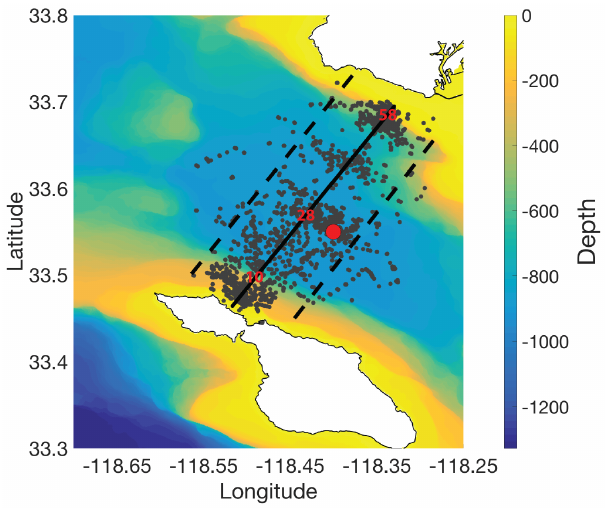
Figure 1. Glider deployment map and idealized glider transect. Slocum electric gliders were deployed in 2013 and 2014 between the Palos Verdes Peninsula and Catalina Island in the San Pedro Channel. The San Pedro Ocean Time-series (SPOT) station, lo- cated at 33 ◦ 33 (cid:48) 00 (cid:48)(cid:48) N and 118 ◦ 24 (cid:48) 00 (cid:48)(cid:48) W, is indicated by the red dot. Glider surfacings are indicated with grey dots. An idealized transect was defined running perpendicular to the mean flow (thick black line). Glider profiles collected within 5km of the idealized transect line (dashed black lines) were used to assess cross-channel variability in oceanographic properties during these glider deploy- ments. The location of bins 10, 28 (closest to SPOT), and 58 are shown in red. The distance from bin 10 to Catalina Island is 5.3km, from bin 10 to bin 28 is 9km, from bin 28 to bin 58 is 15km, and from bin 58 to the closest point on the mainland is 4.8km. The bathymetry of the study area is designated by the color contours and ranged from ∼ 20 to 900m. The maximum glider dive depth was